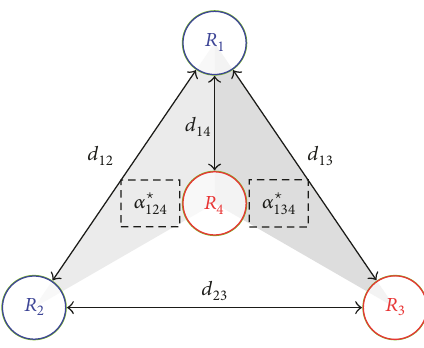
Figure 6: Simulation 2 setup of the distance and area based formation control with 𝑛 = 4 and 𝑛 1 = 2 .